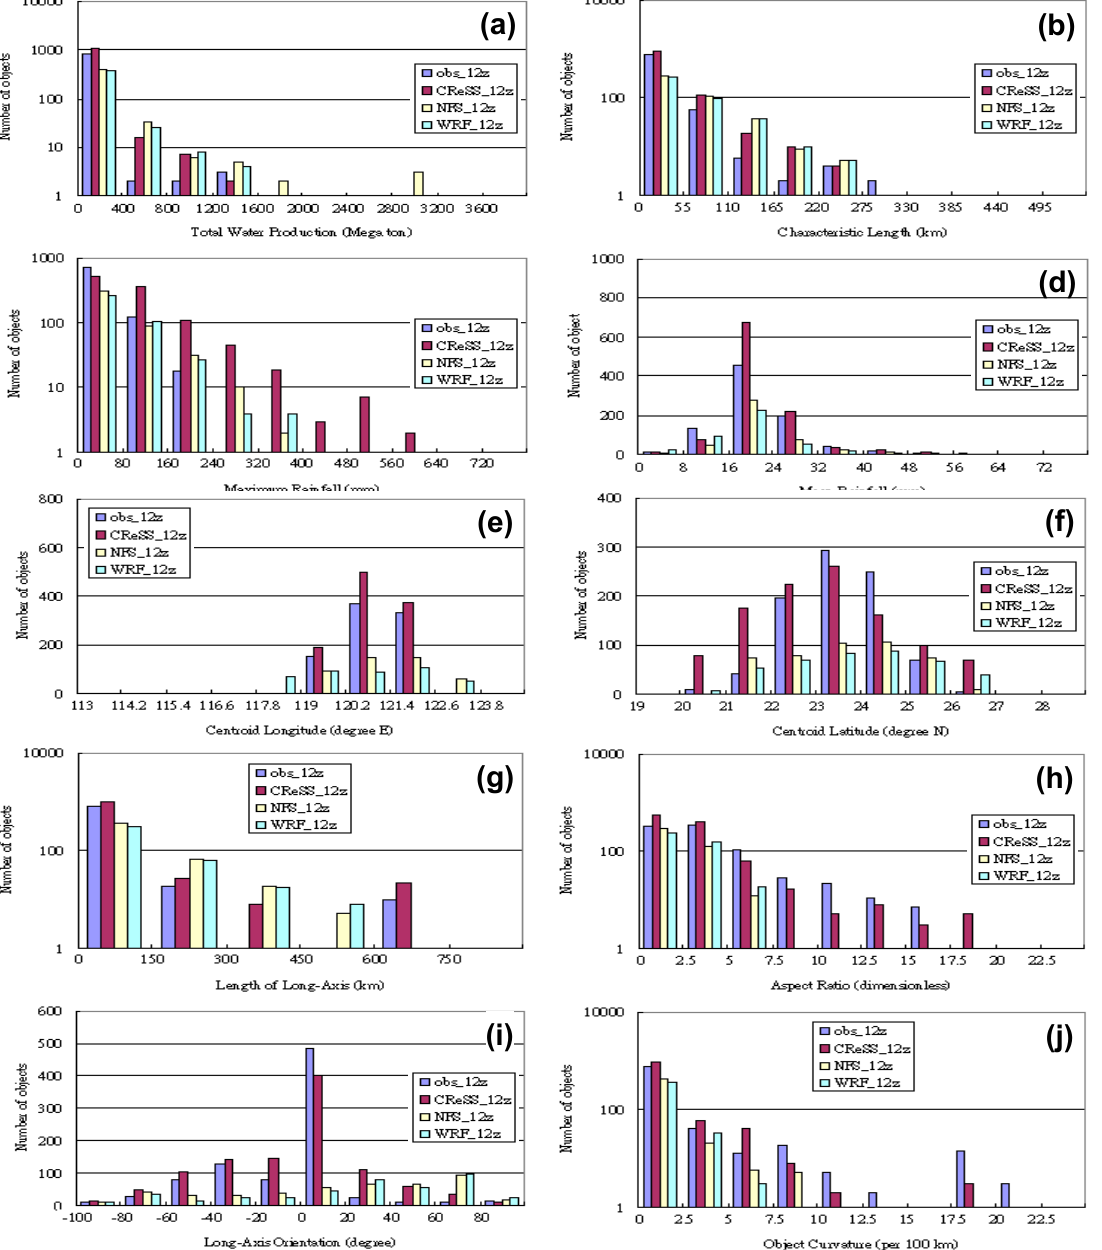
Figure 3. As in Figure 2 ( a – j ) but for (12–36 h) forecasts initialized daily at 1200 UTC. A total of 863, 1067, 408, and 448 objects are identified in observation, CReSS, WRF, and NFS, respectively.